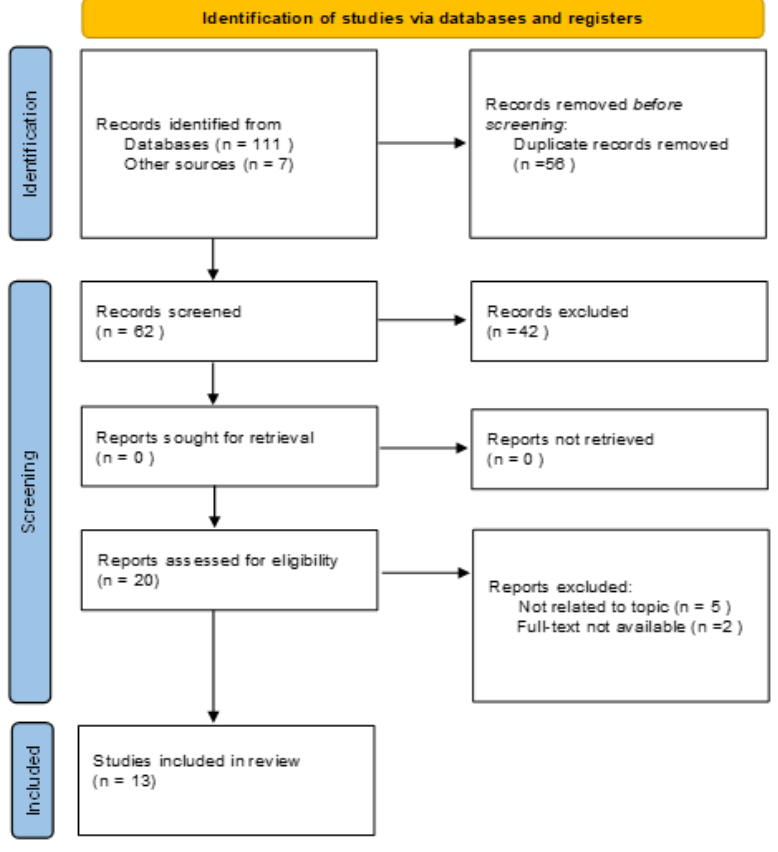
Figure 1. PRISMA flow-chart.